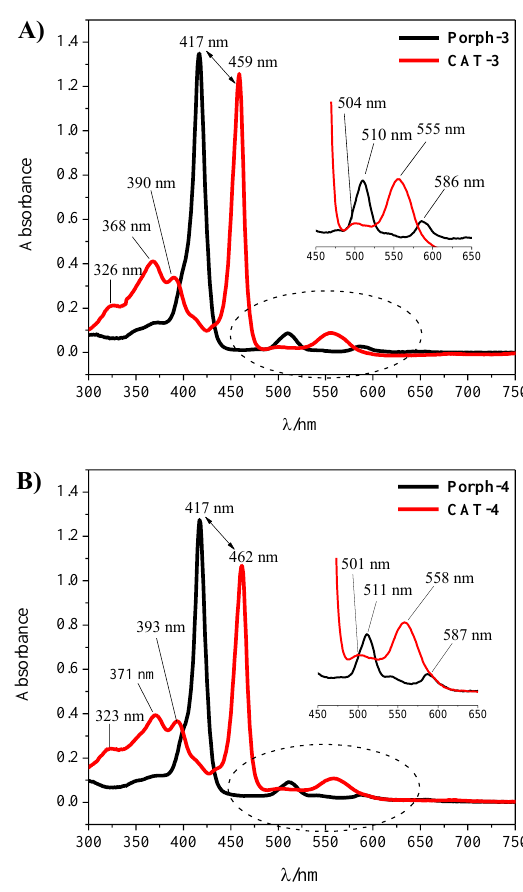
Figure 2. UV–VIS spectra obtained before and after the complexation of ( A ) Porph-3 ; ( B ) Porph-4 with manganese. The spectra were acquired using chloroform as solvent for the free-base porphyrins and methanol for the Mn(III) complexes.